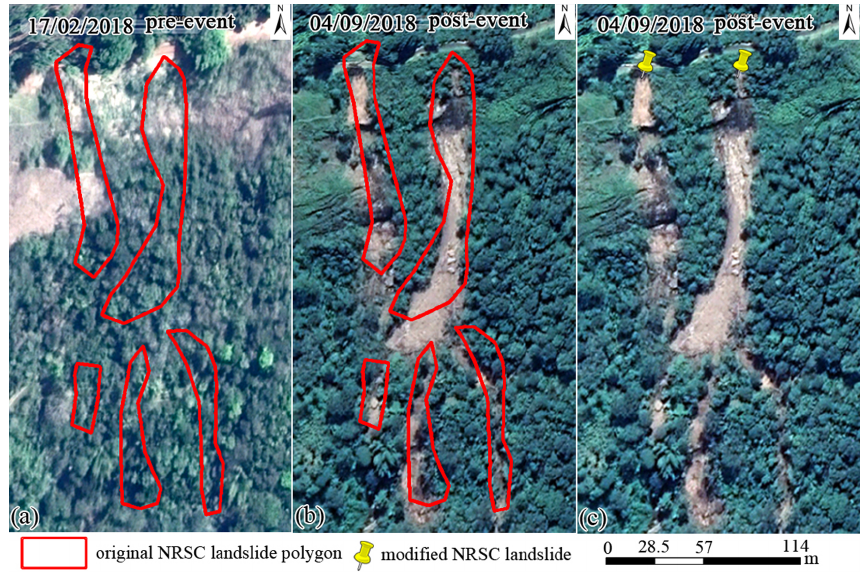
Figure 5. Example of a situation where the original NRSC landslide polygons were combined and converted into points and digitized on the top of the scarps: (a) pre-landslide image, (b) post-landslide image, and (c) final inventory using points. Basemap data © Google Earth 2019.